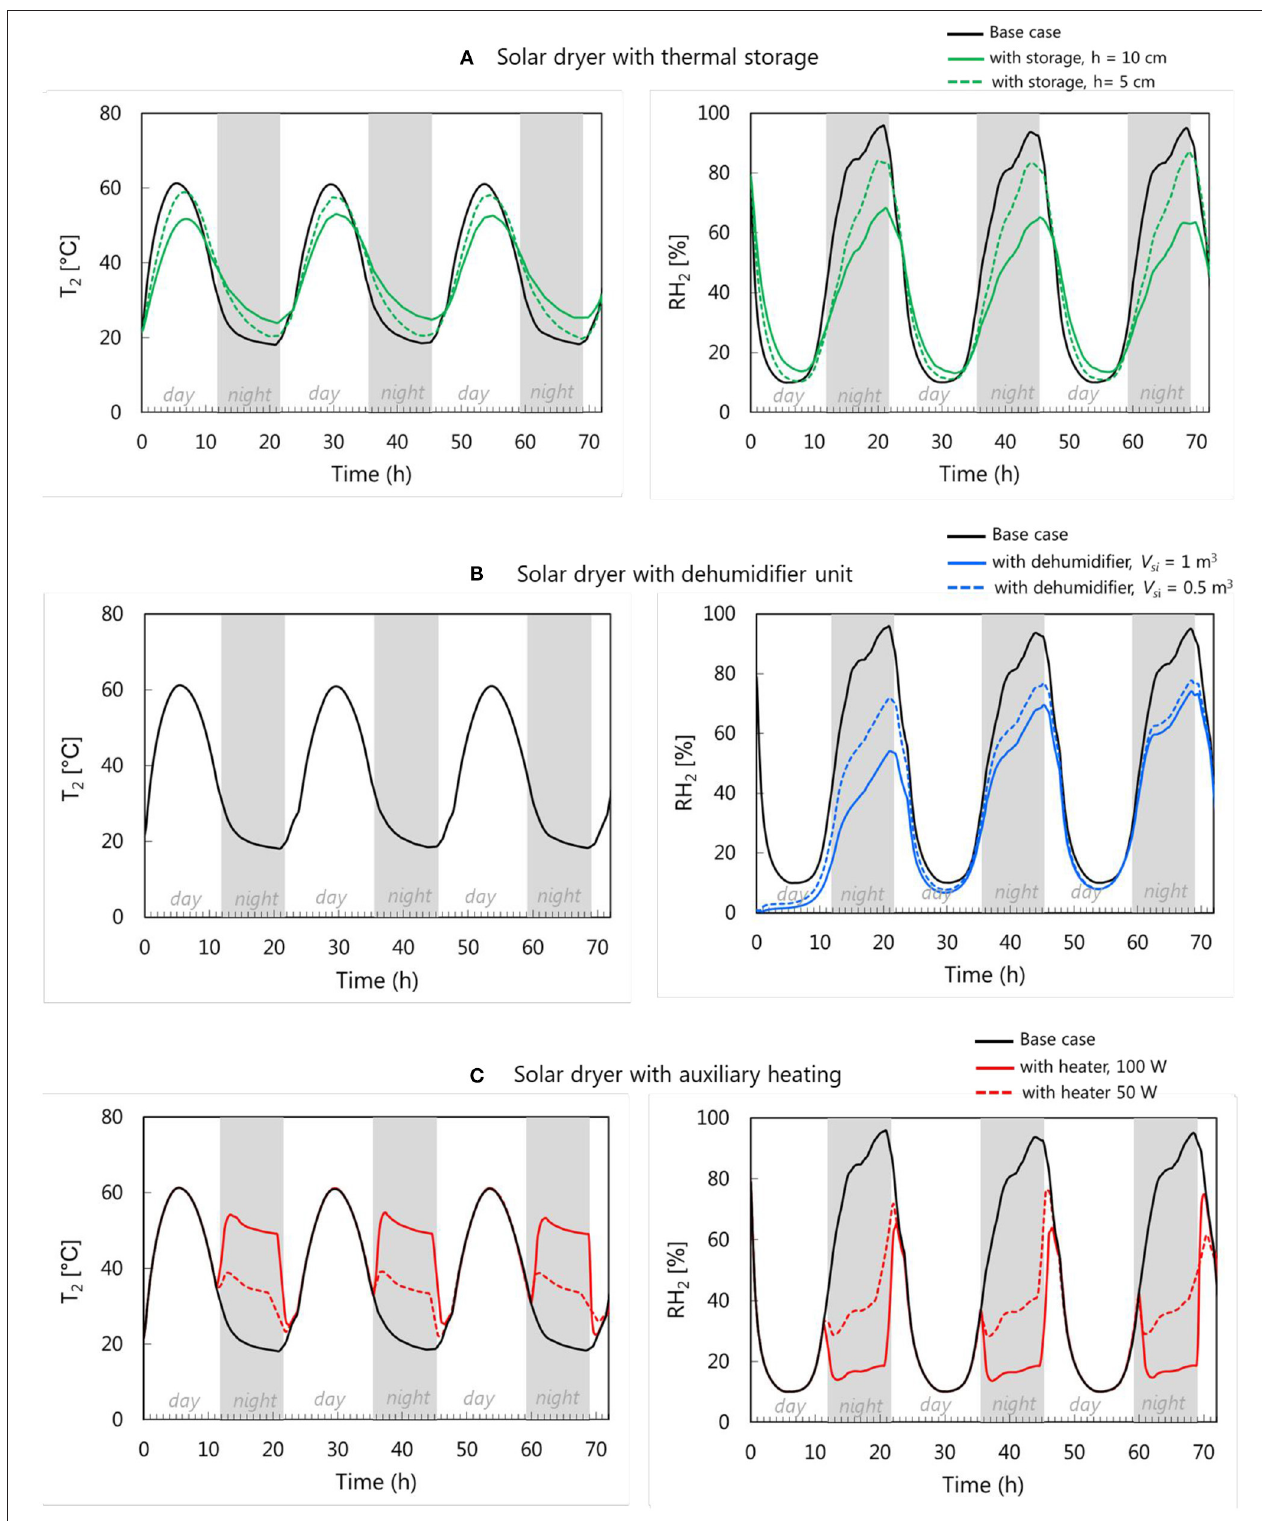
FIGURE 5 | Solar collector air outlet temperature T 2 and relative humidity RH 2 for solar drying equipped with (A) thermal storage, (B) dehumidifier unit, and (C) auxiliary heating.